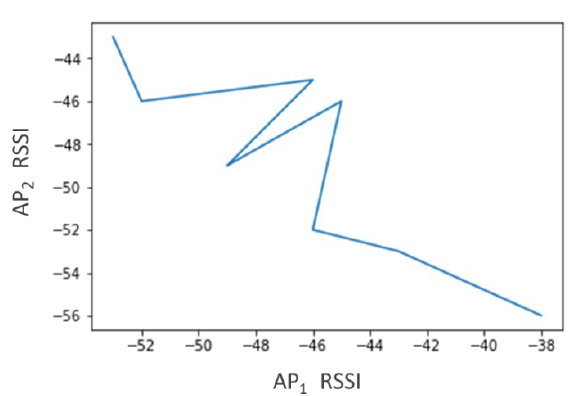
Figure 17 RSSI distributions of AP 2 vs. AP 1 after location